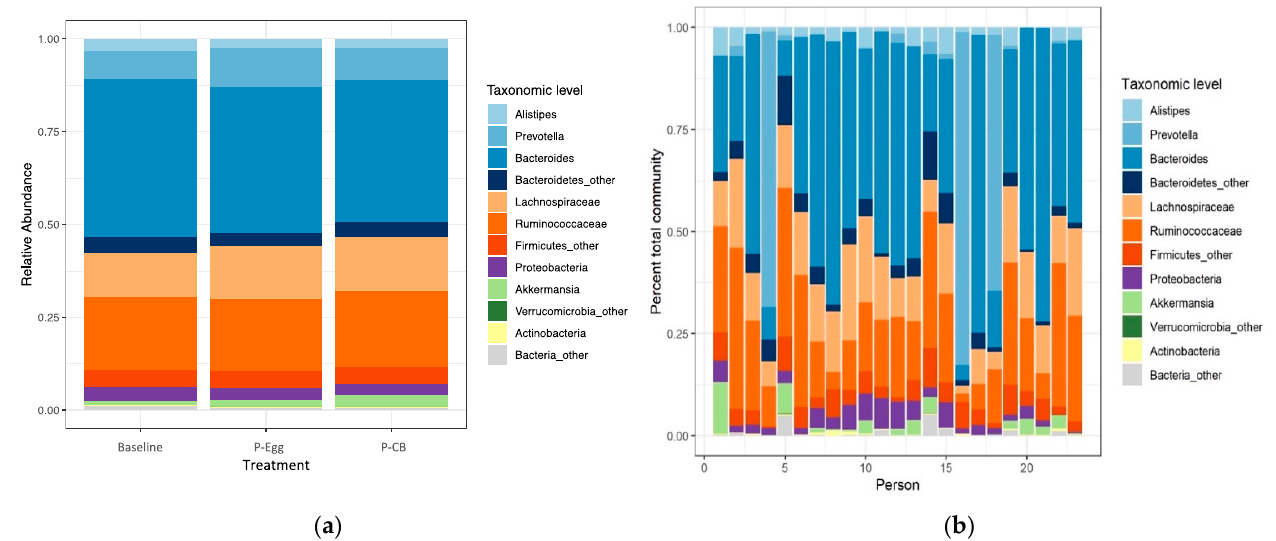
Figure 6. Relative abundance of the gut microbiota ( a ) based on treatments ( b ) and individual average throughout the intervention.